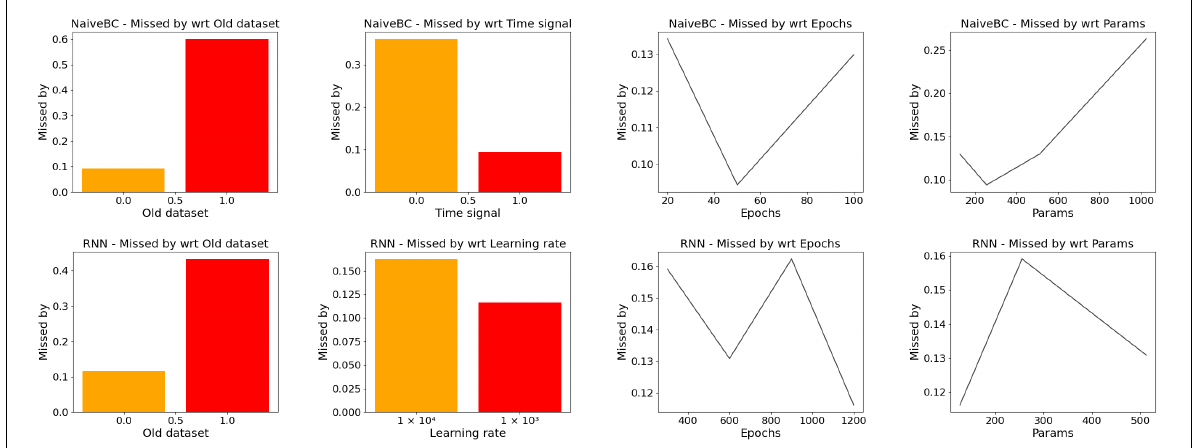
Figure 7. Results—best mean throw error performance for each hyperparameter value, in units of meters. The top row shows feedforward model results, the bottom—RNN. In both cases, the smaller, newer dataset with less variance in orientation and target coordinates results in better throw evalua- tions. Introducing the time signal significantly improves feedforward model performance, whereas for the RNN, improved results could be attained at higher learning rates. In the case of the feedfor- ward model, training for too long and making the model too large initially appears to be detrimental, while for the RNN, no clear trend was observed in this respect.